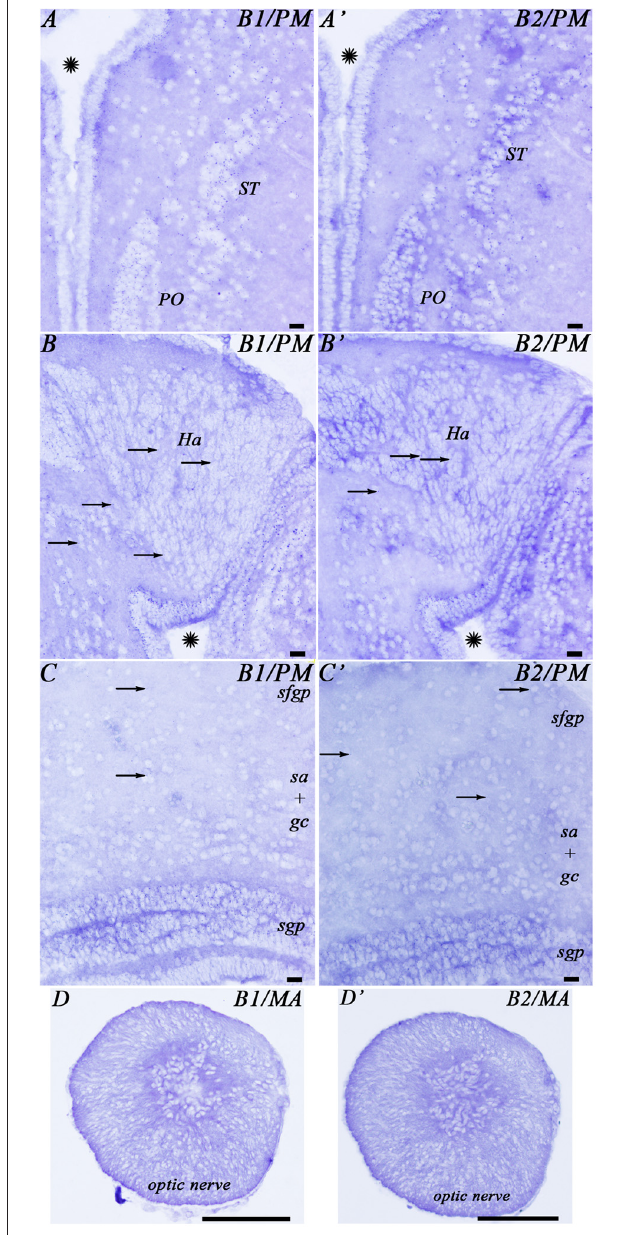
FIGURE 3 | Photomicrographs from the sea lamprey brain showing the expression of both GABA B subunits in the same brain regions. (A–D) corresponds to GABA B1 expression and (A (cid:48) –D (cid:48) ) corresponds to GABA B2 expression. The arrows indicate some small positive dots. Please note in (D,D (cid:48) ) that the astrocytes are located in the central part of the optic nerve. Asterisks indicate the ventricles. Abbreviations as in Figure 4 . Scale bars = 50 µ m.